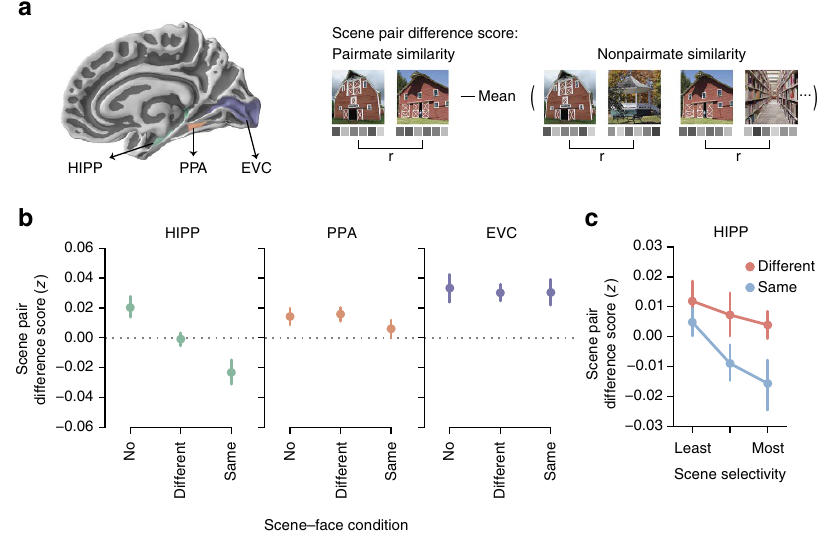
Figure 2 | Learning reduces representational overlap in the hippocampus. ( a ) ROIs included scene-preferring voxels in hippocampus (HIPP), parahippocampal place area (PPA) and early visual cortex (EVC). Note: we use ‘HIPP’ to specifically refer to the ROI we used, and not to the hippocampus in general. ROIs are displayed on the right hemisphere of the Freesurfer average cortical surface in the Figure, but were defined bilaterally in each subject’s native space for all analyses. For each subject, a neural activity pattern was estimated for each scene. Neural similarity was operationalized as Fisher z - transformed Pearson’s correlations between scene patterns. For each scene pair, a scene pair difference score was computed by subtracting the mean within-condition nonpairmate similarity from the pairmate similarity. This difference score reflected the relative representational distance between pairmates. ( b ) Prior learning (Different Face and Same Face conditions) decreased representational overlap between pairmates (lower scene pair difference scores) in HIPP (main effect of scene-face condition: F 2,34 ¼ 7.75, P ¼ 0.0017), but not in PPA (Friedman w 2 2 : 11, P ¼ 0.35) or EVC ( F 2,34 ¼ 0.074, 2 ¼ P ¼ 0.93). ( c ) For the Different and Same Face conditions, decreased representational overlap (lower scene pair difference score) was most evident in voxels with the greatest scene selectivity ( F 2,34 ¼ 3.98, P ¼ 0.028). Plotted data represent mean ± s.e.m. across subjects. See also Supplementary Fig.